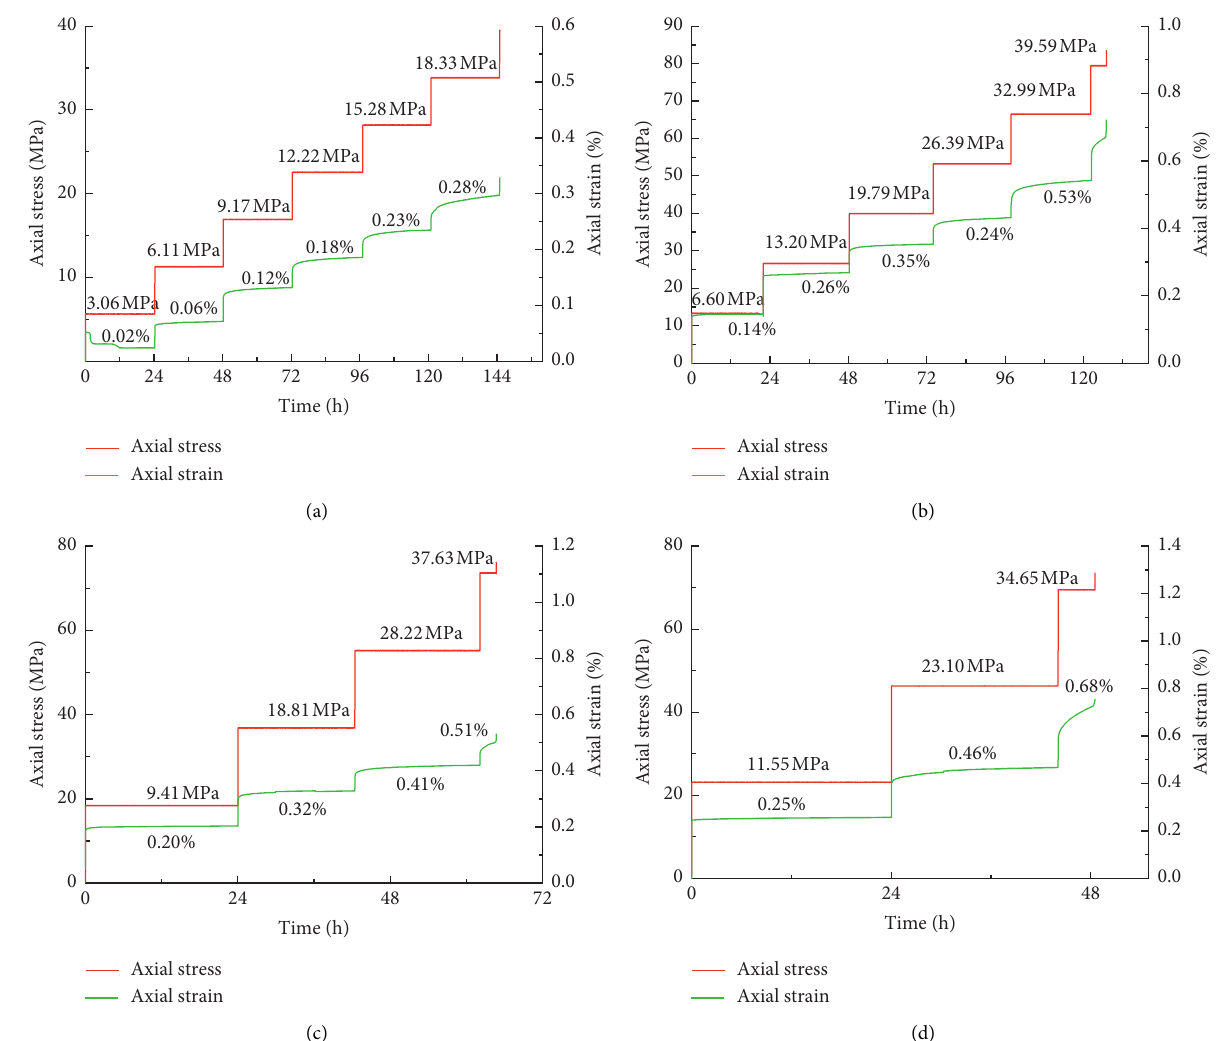
Figure 4: Step loading time-stress-strain curves of rock-concrete composite specimens under different confining pressures. (a) Confining